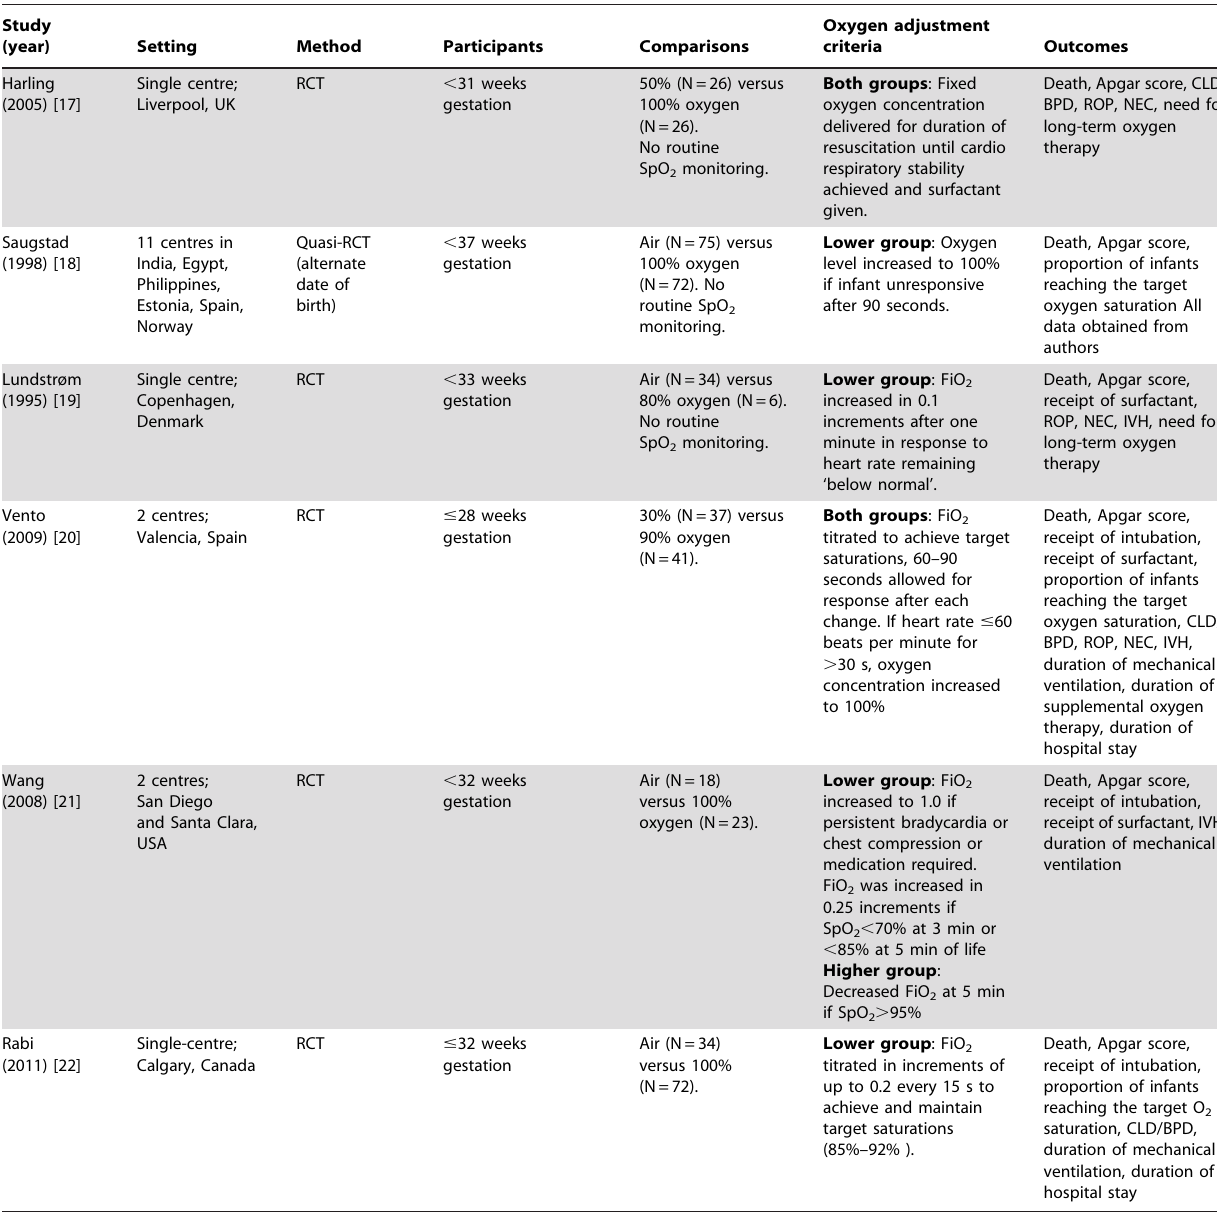
Table 3. Characteristics of included